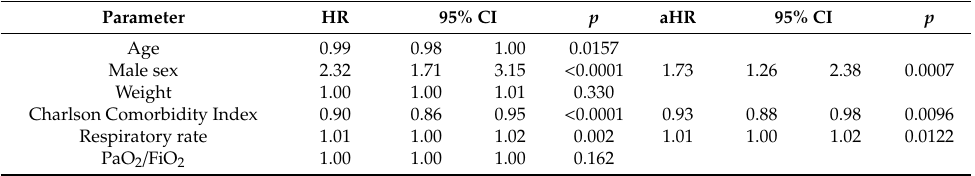
Table 4. Crude (HR) and adjusted hazard ratio (aHR) for LEE grade ≥